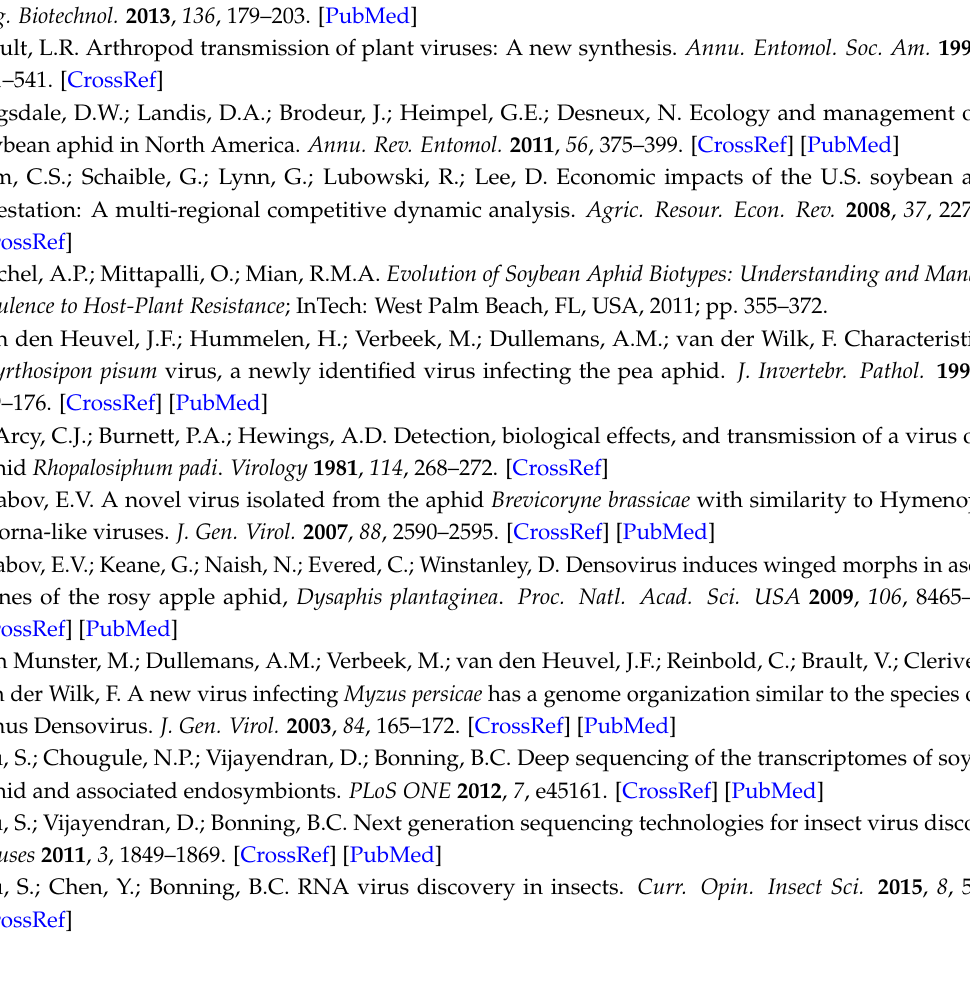
Figure S1: Gel electrophoresis (1% native agarose) of 2 µ g RNA extracted from purified ApGlV2 and ALPV-AP virions. While the ALPV-AP RNA runs at the expected size of ~10 kb, the ApGlV2 RNA runs as a smear indicative of RNA degradation. Samples visualized with ethidium bromide staining; Figure S2: Peptide sequences derived from ApGlV2 structural proteins. Peptide numbers correspond to protein bands in Figure 3B; Colors represent sequences of individual peptide fragments. Proteins were identified from these peptide sequences with high confidence based on Mascot search A2 values; Figure S3: Detection of ApGlV2 RdRp sequence from field collected A. glycines . The 929 bp RT-PCR product was detected in field collected A. glycines from Iowa, Ohio and Michigan, USA. The positive control and A. glycines samples amplified the expected PCR products. No amplification was detected in the no template control sample (NTC); Figure S4: ApGlV2 sequences were not detected in the A. glycines genome. Primers spanning the entire ApGlV2 genome were used to test for the presence of ApGlV2 sequence in the A. glycines genome. A representative agarose gel with amplified PCR products is shown. Labels indicate region of ApGlV2 genome spanned by the PCR primers. CP, capsid protein; RTD, read through domain; RdRp, RNA-dependent RNA polymerase. The sequenced PCR product from A and B did not have any significant matches to ApGlV2 or the NCBI database. PCR product C hit a pea aphid prestin-like transcript variant